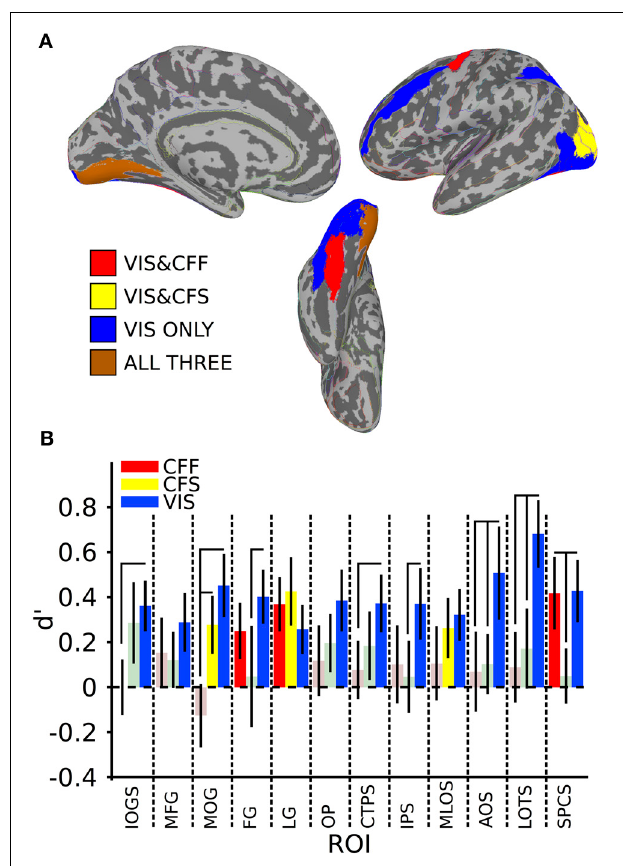
FIGURE 2 | Within-method classification results. (A) Colored anatomical ROIs indicate regions where classification of stimulus category was significantly above-change ( p < 0 . 05 FDR-corrected) for each presentation method. (B) Bar graphs showing the classification accuracy for each method within all ROIs where above-chance classification was possible for the visible presentation method. Saturated (yellow, blue, and red) colors indicate significant classification, whereas desaturated (light red, light green) colors indicate non-significant classification. Full region names for the ROI abbreviations can be found in Table 1